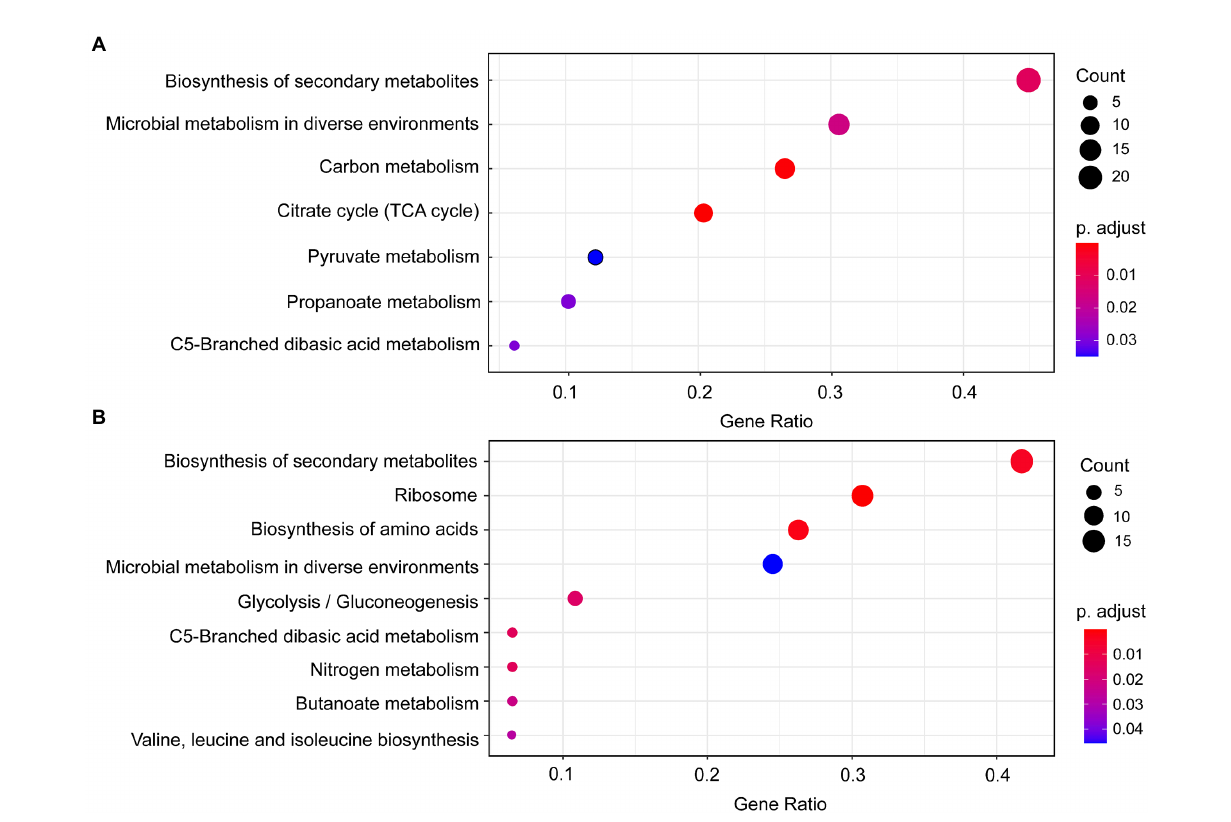
FIGURE 3 KEGG pathway enrichment of the DEPs in B. pumilus (B18 vs. B40) (A) and K. vulgare (K18 vs. K40) (B) . A redder color represents a greater p- value, and a larger circle represents a greater number of